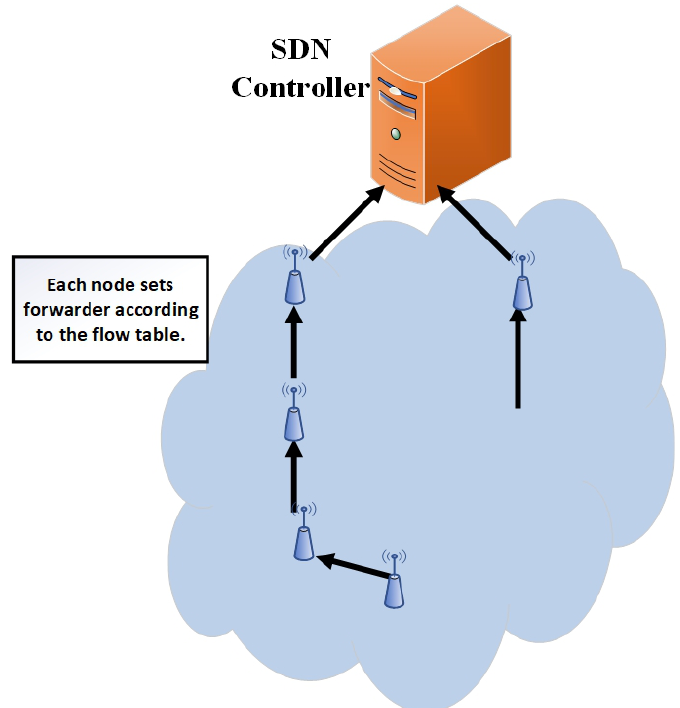
Figure 6. Routing path